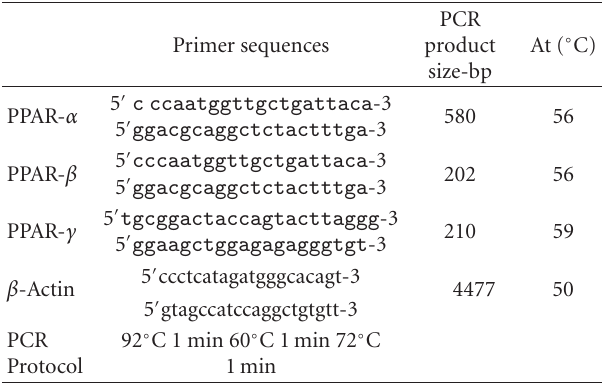
Table 5: Primer sequences of PPAR- α , PPAR- β , PPAR- γ , β